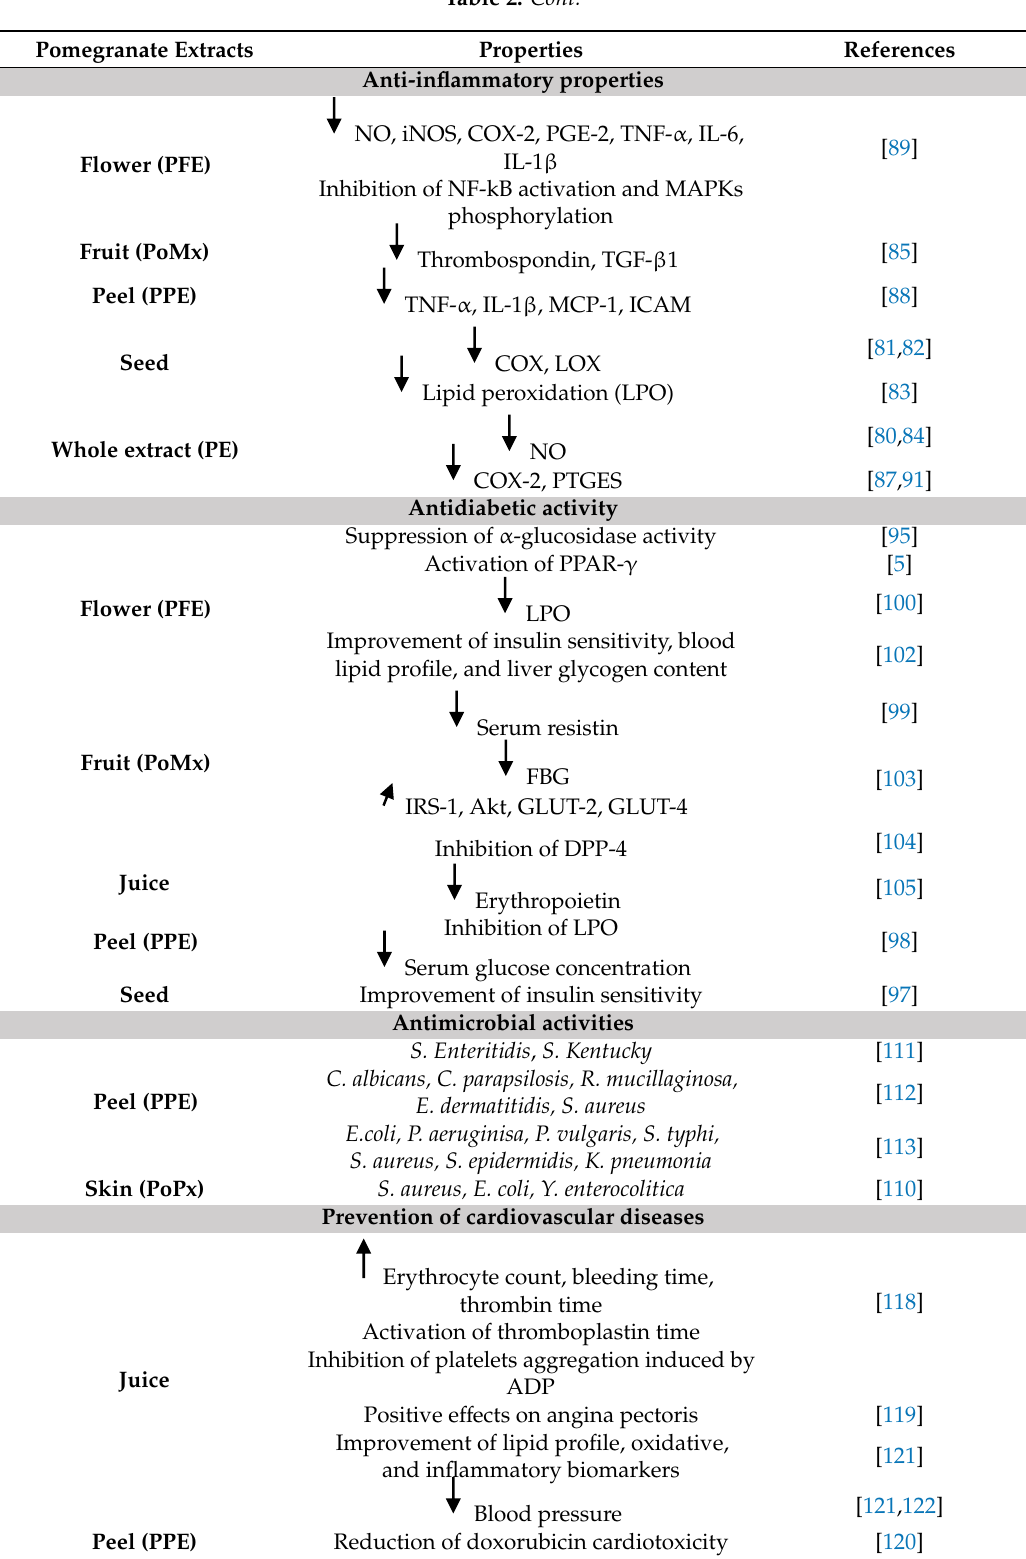
Table 2. Biological properties of different pomegranate